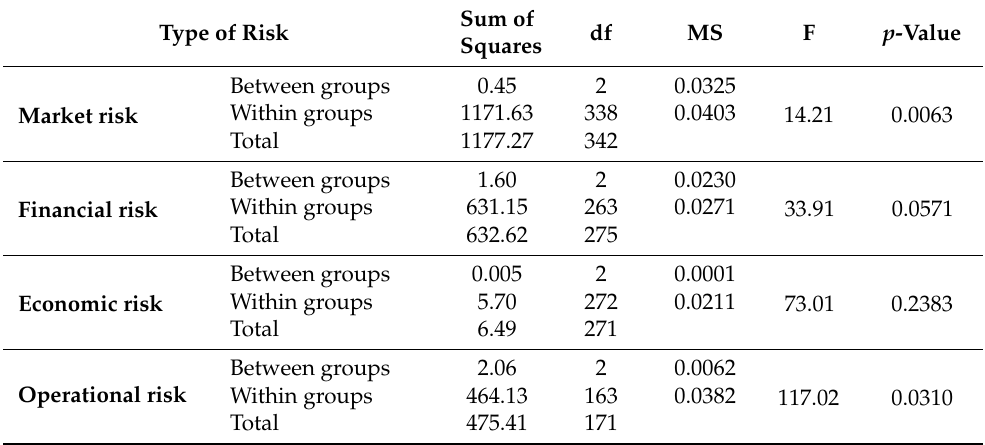
Sum of df MS F p -Value Squares